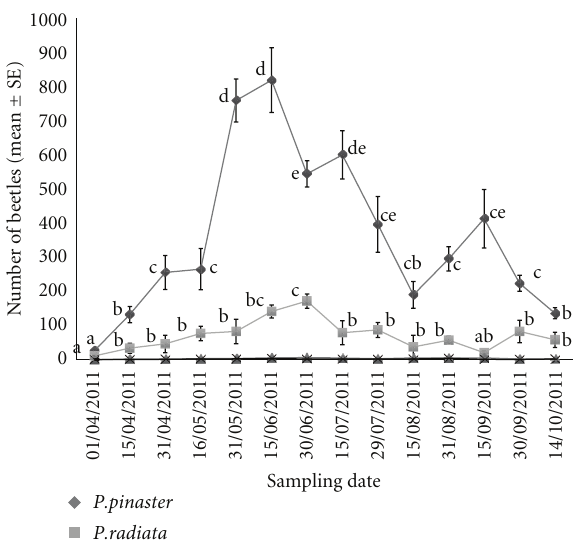
Figure 2: Number (mean ± SE) of Ips sexdentatus (B¨orner) (Coleoptera: Curculionidae: Scolytinae) captured in Pinus pinaster Aiton (Pinales: Pinaceae) (dark grey) and P. radiata D. Don (light grey) sawmills from 1 April to 14 October 2011 . Dates within each Pinus L. species with di ff erent letters are significantly di ff erent at a significance level of α = 0 . 05. Control catches in both cases were insignificant to perform any statistical